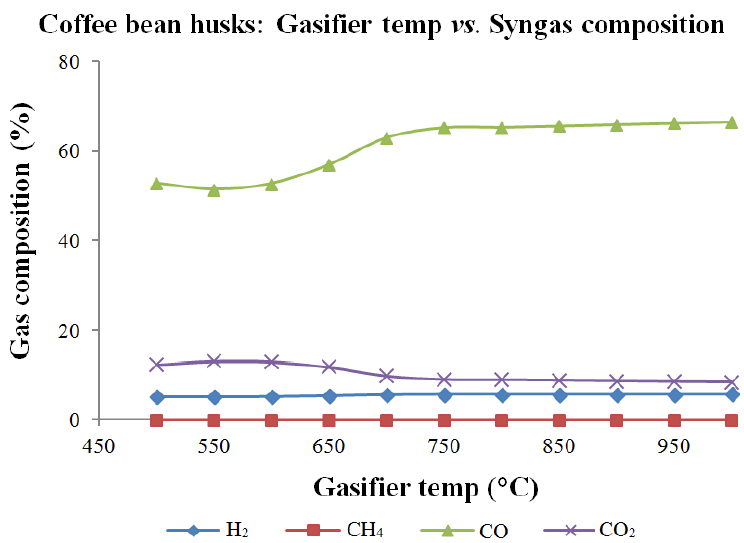
Figure 10. Effect of gasifier temperature for coffee bean husks (air-fuel ratio: